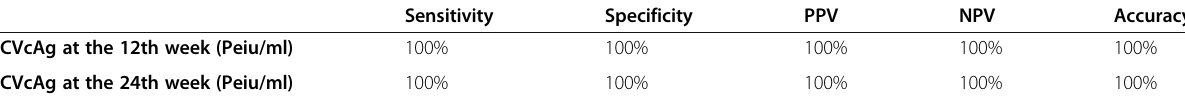
Table 8 Evaluation of HCVcAg assay performance in prediction of treatment response at the 12th and 24th week among the studied